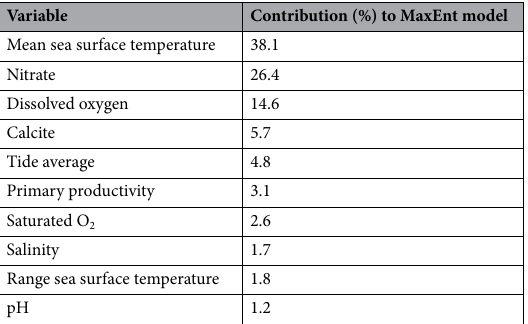
Table 1. Variable contribution in habitat suitability model of the Metopograpsus thukuhar / cannicci species complex .